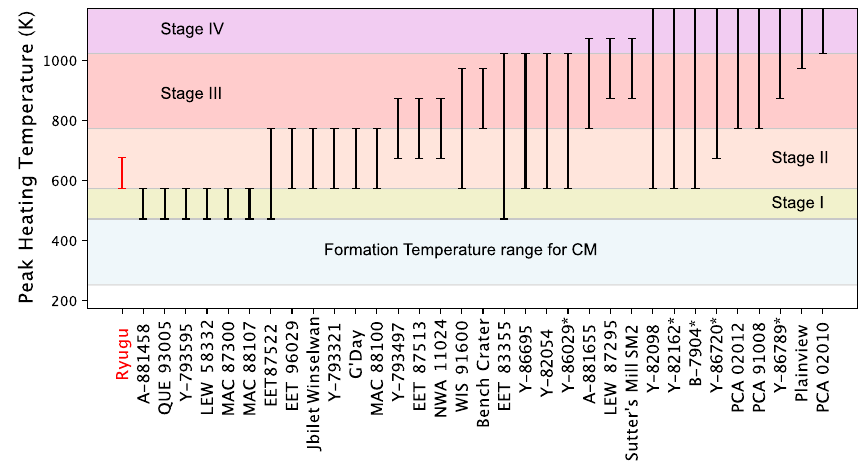
Fig. 10 Estimated heating temperature for Ryugu and ATCCs. Peak heating temperatures for meteorites were estimated by refs. 49, 50, 61 . The thermal metamorphism stages I – IV are de fi ned by ref. 50 . Stage 1: low heating temperature of <570 K (<300 °C), Stage II: heating temperature of 570 – 770 K (300 – 500 °C), Stage III: heating temperature of 770 – 1020 K (500 – 750 °C), and Stage IV: high temperature of >1020 K (>750 °C). The meteorites